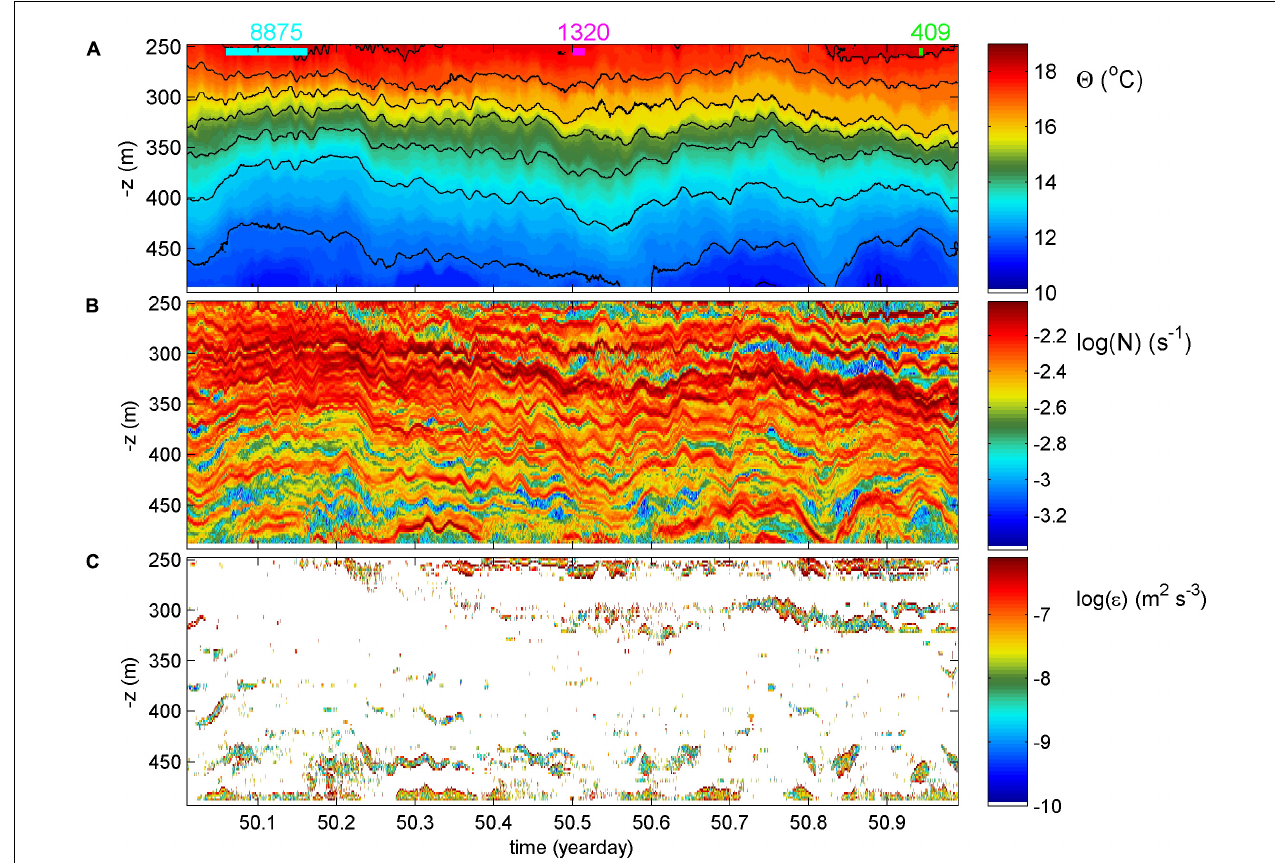
FIGURE 10 | As Figure 9 with identical ranges, but for Figure 5B ,